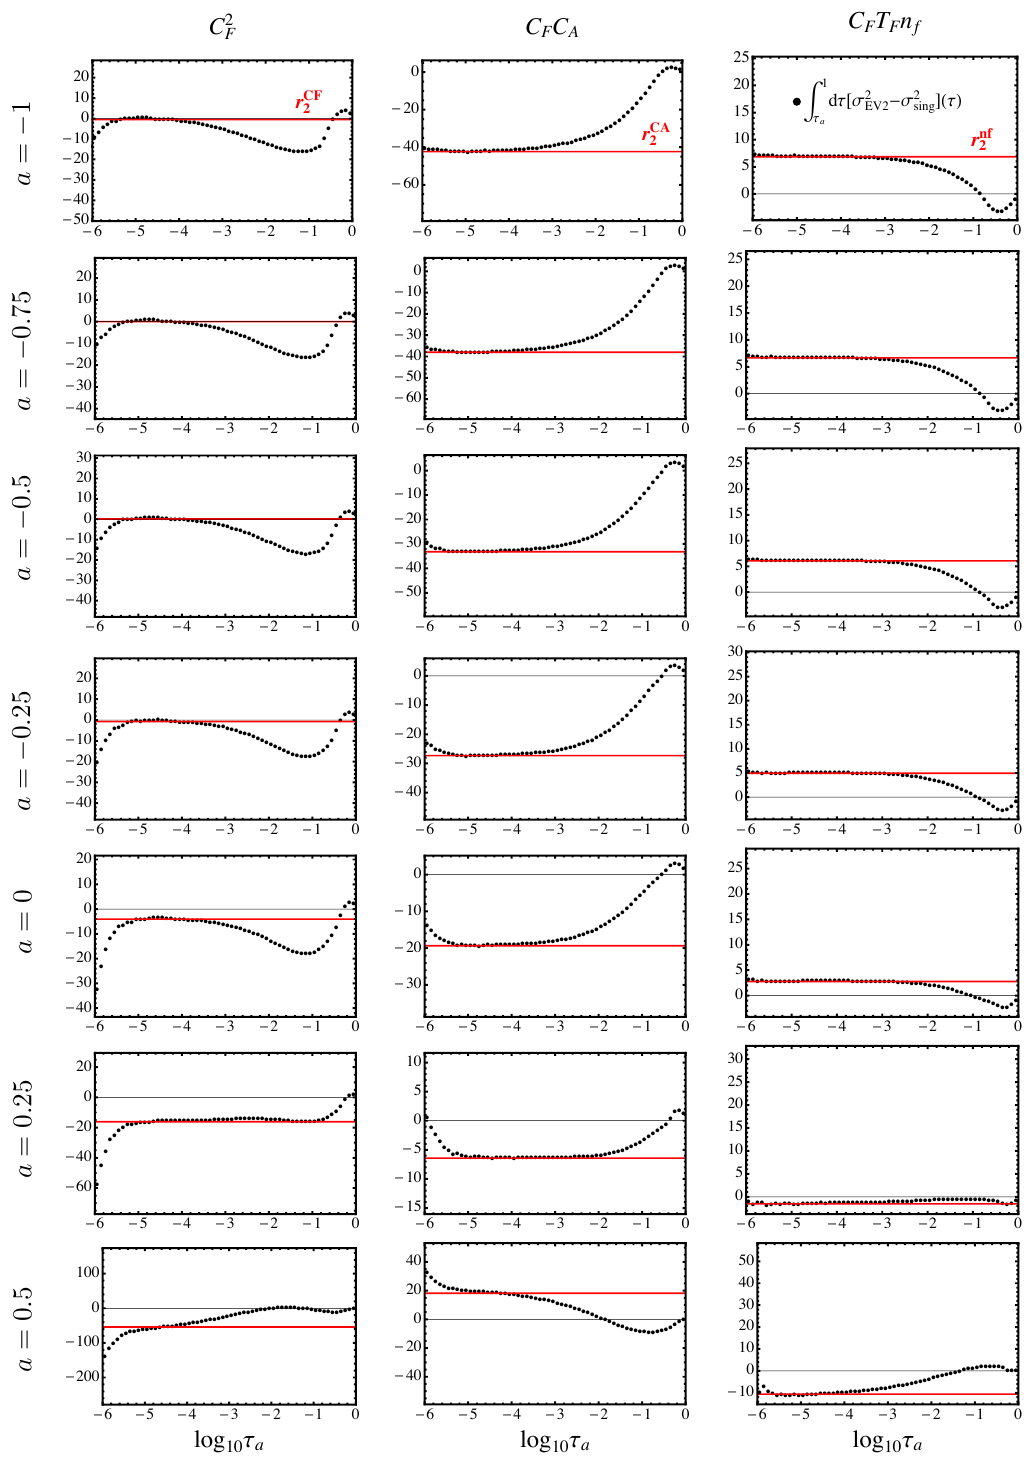
Figure 6 . Integral eq. (3.14) of the lower integration limit (cid:28) a . Shown are the coe(cid:14)cients of the C 2 Our best (cid:12)t values for the constants r CF